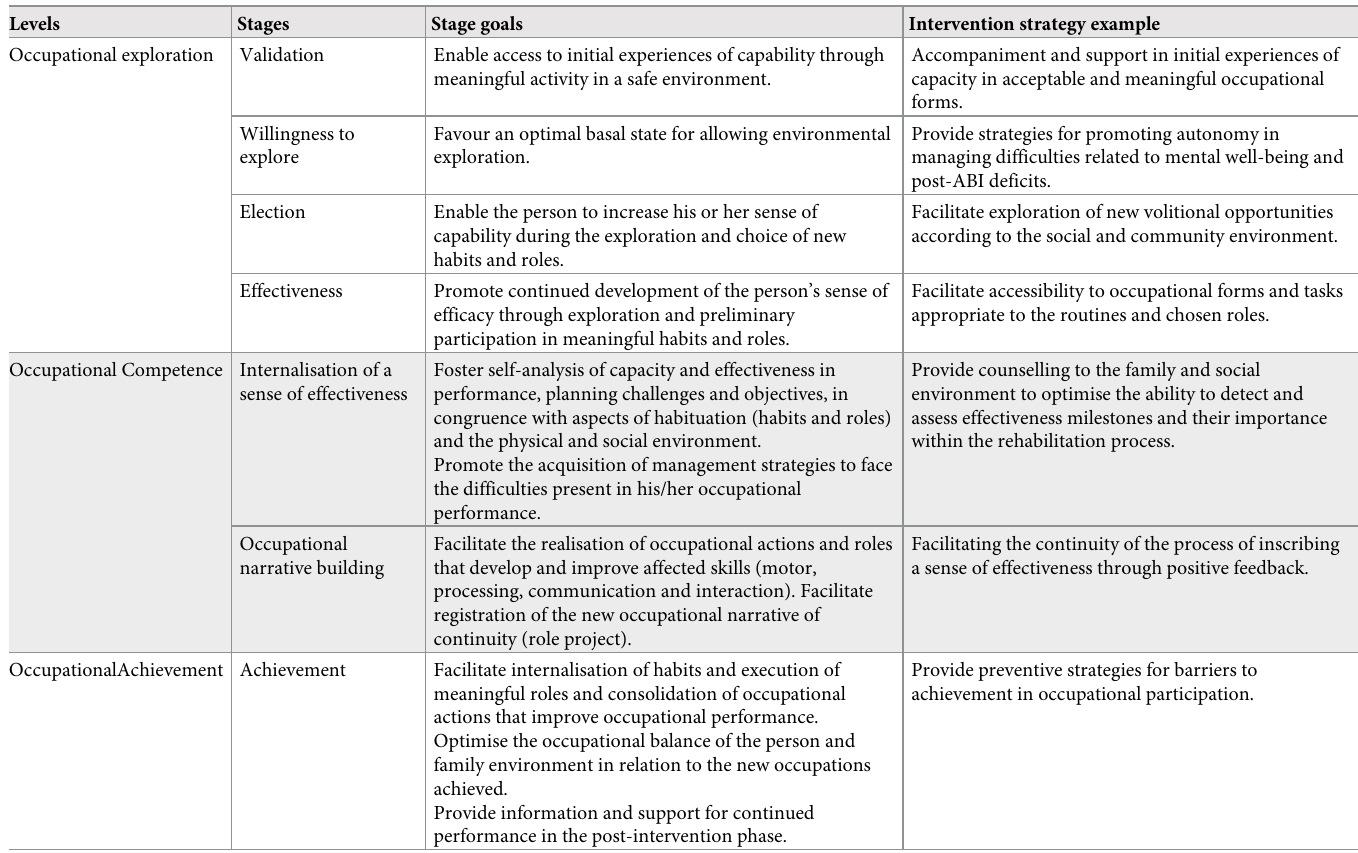
Table 1. Composition of the intervention process